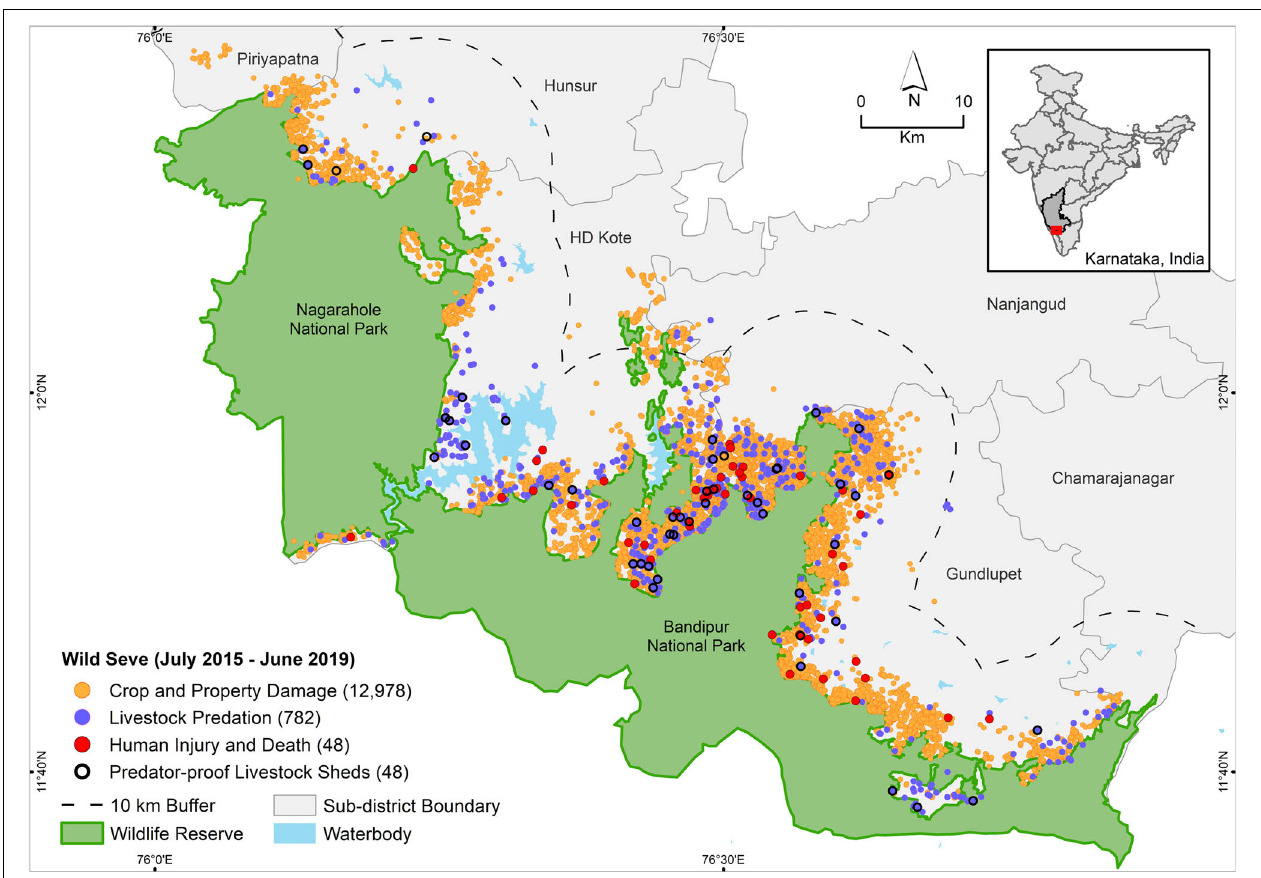
FIGURE 1 | Map of the Bandipur-Nagarahole region showing incidents of human-wildlife conflict registered by Wild Seve. Predator-proof livestock sheds ( n = 48) were built around the landscape to serve as models of mitigation